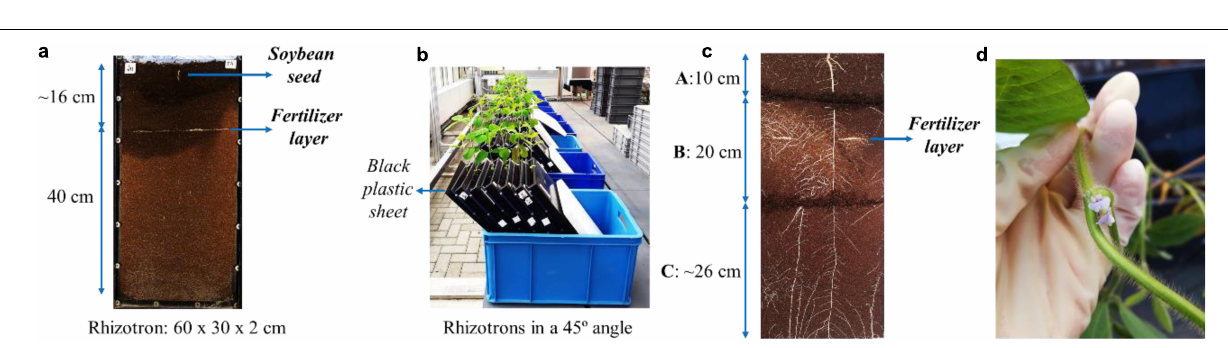
FIGURE 2 | (a) Rhizotron with a fixed layer of fertilizer and pre-germinated soybean seedling; (b) Rhizotrons during cultivation; (c) Substrate and root sampling in layers A (top layer, 10 cm), B (middle layer, 20 cm, including the fertilizer layer), and C (bottom layer, ∼ 26 cm); (d) Flower bloom 30 days after